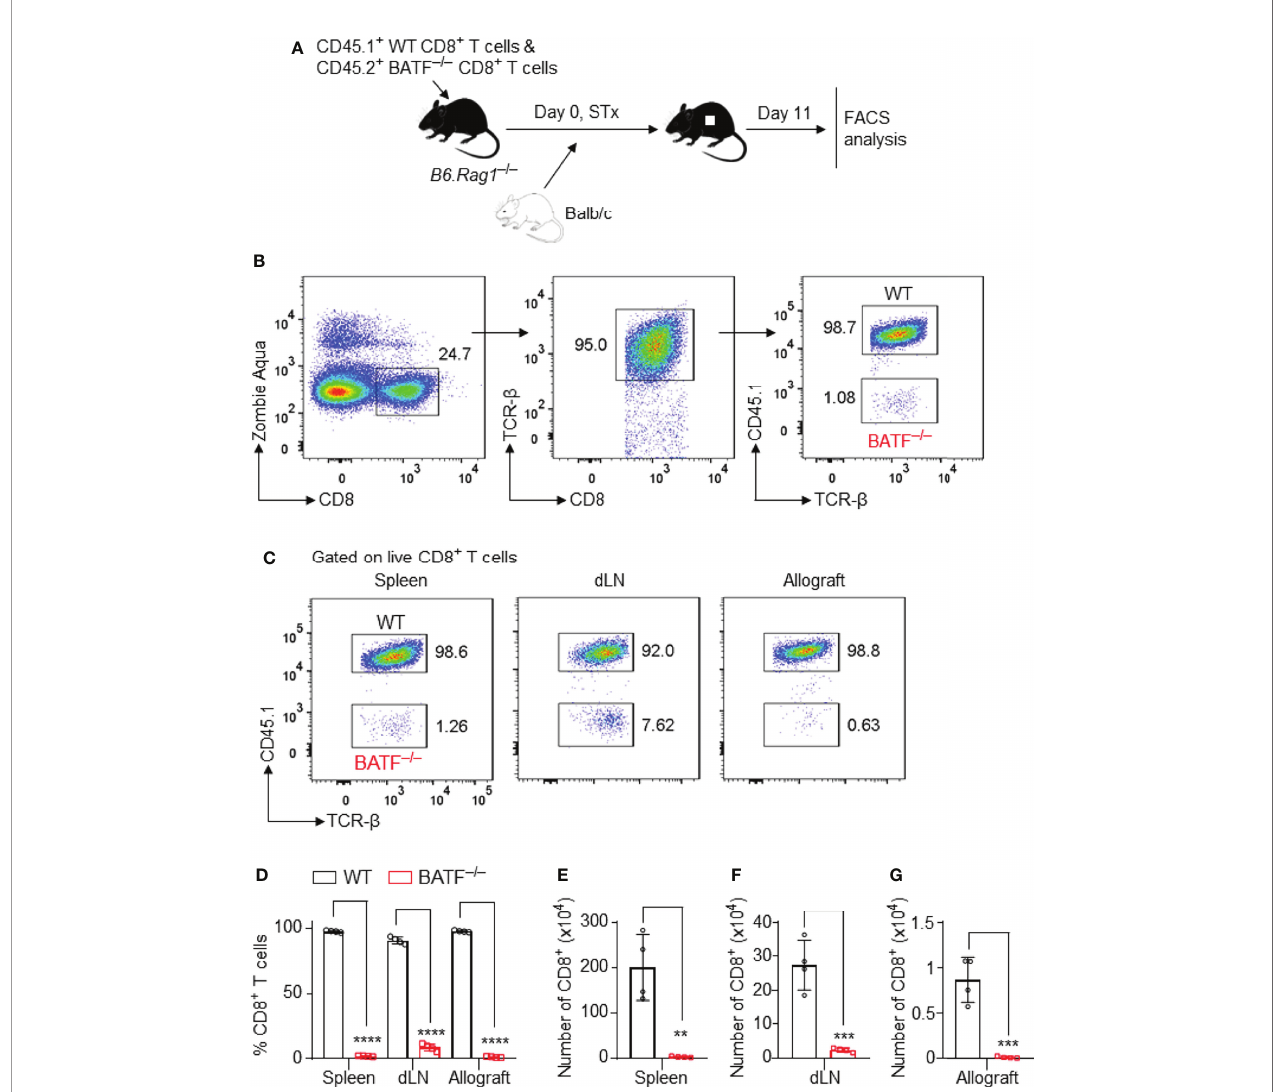
FIGURE 2 | BATF-suf fi cient CD8 + T cells outcompete their BATF-de fi cient counterparts in in fi ltration into skin allografts. B6. Rag1 – / – recipients were adoptively transferred with a mixture of 0.5 x 10 6 CD45.1 + WT CD8 + T cells plus 0.5 x 10 6 CD45.2 + BATF – / – CD8 + T cells, followed by Balb/c skin transplantation. The frequencies of the transferred CD8 + T cells were determined on day 11 post skin grafting. (A) Schematic of the experimental design. (B) Gating strategy for detecting live WT and BATF – / – CD8 + T cells. (C, D) Representative plots and bar graphs show the percentages of the CD45.1 + WT and CD45.2 + BATF – / – cells among live CD8 + T cells. (E – G) Bar graphs display the absolute cell numbers of WT and BATF – / – CD8 + T cells. Data represent the mean ± SD (n = 4). ** p < 0.01, *** p < 0.001, **** p < 0.0001; (unpaired Student ’ s t